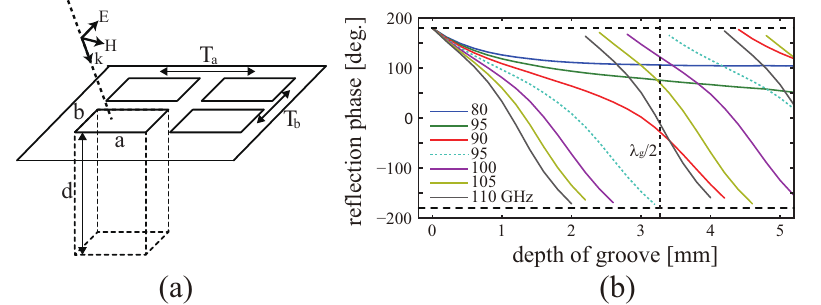
Figure 1. ( a ) Single unit waveguide as a metal reflectarray building block with a = 1.8 mm, b = 1.4 mm, T a = 2.3 mm, and T b = 1.9 mm and ( b ) simulated reflection phase values of the unit cell in degree varying d, the depth of a waveguide for some frequency